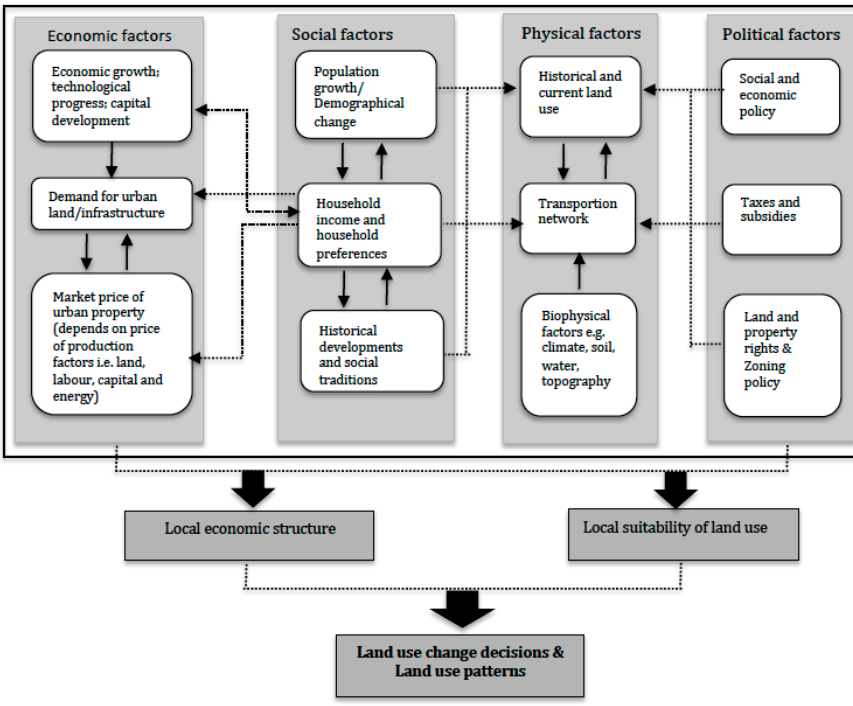
Figure 1. The factors influencing land-use change and pattern.